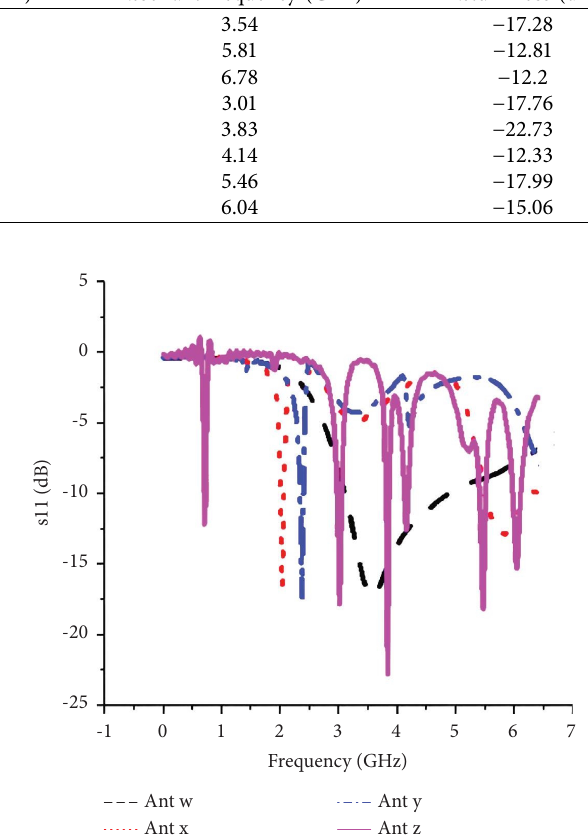
Figure 3: S 11 comparison plot of antennas w, x, y, and